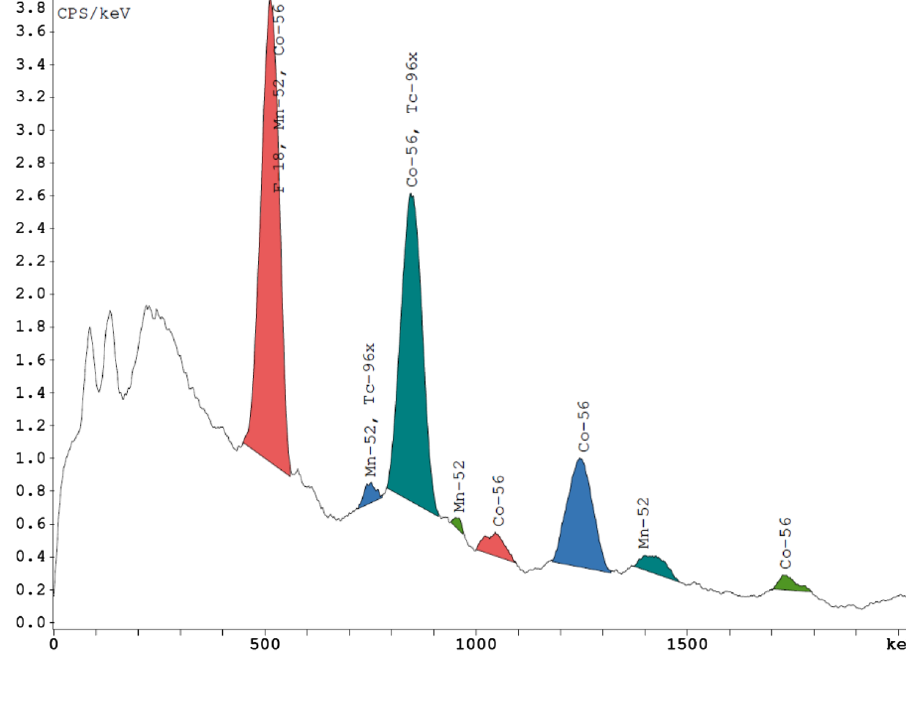
Fig. 2 Gamma spectroscopy data of the bombarded [O-18] water of a single FDG